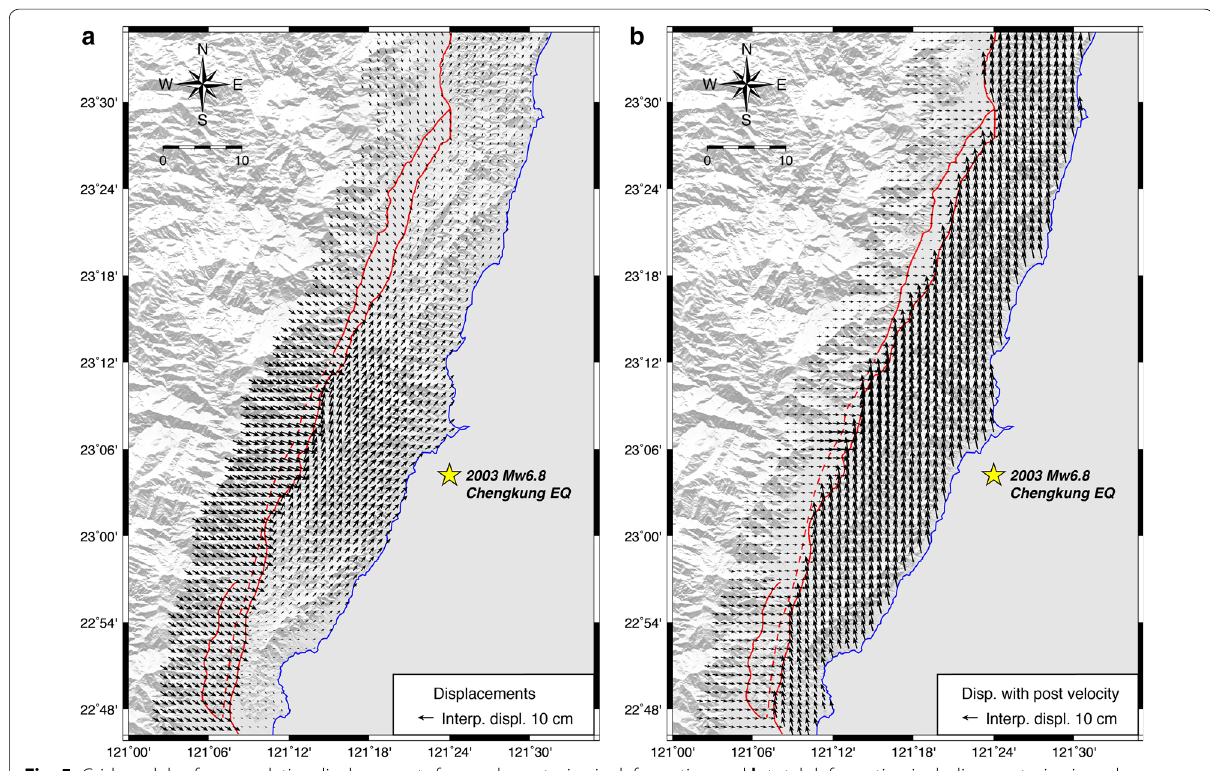
Fig. 5 Grid models of accumulative displacements for a only postseismic deformation and b total deformation including postseismic and interseismic movements. Time span of the accumulative displacements is from the 2003 Chengkung earthquake to 2006 Taitung earthquake. Yellow star denotes the epicenter of the Chengkung earthquake. Red lines are the active faults shown in Fig. 1. Figure 5a provides amount of postseismic displacements, which can be used to calculate how much postseismic deformation occurred. Figure 5b shows amount of total displacements after the earthquake, which can be used to justify if the total displacements exceed the tolerance of the reference